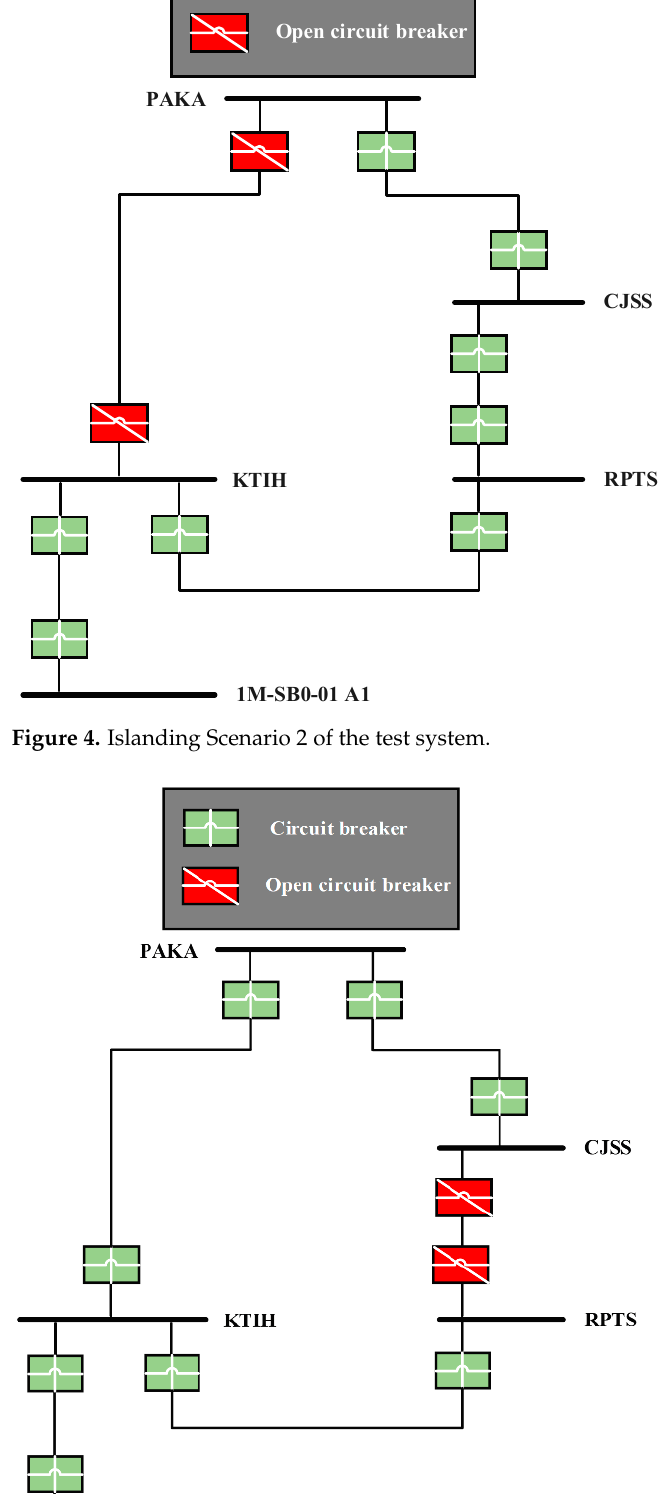
Figure 5. Islanding Scenario 3 of the test system.